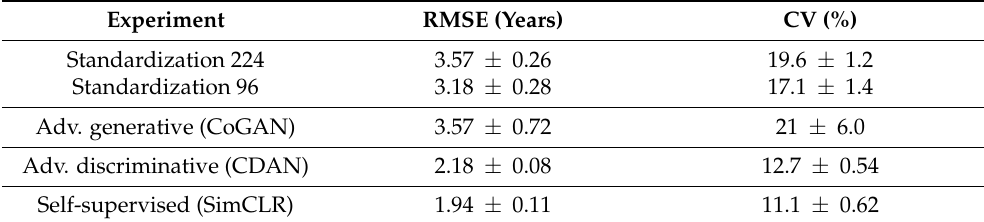
Table 3. Summary of the performances achieved on the experiments that are considered as domain adaptation, i.e., simple standardization approach and the UDA methods. For each experiment, the model was trained 5 times (using 5 different random number generators) and we reported the averaged RMSE/CV and standard deviation over the 5